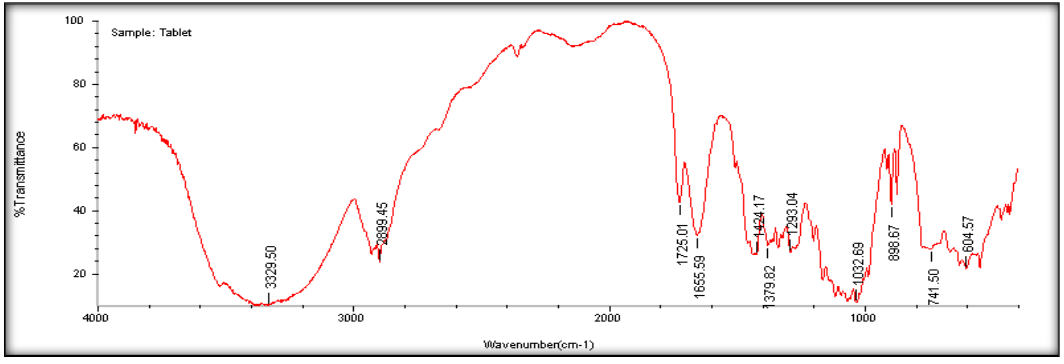
Figure (7): FTIR spectrum of eztimibe